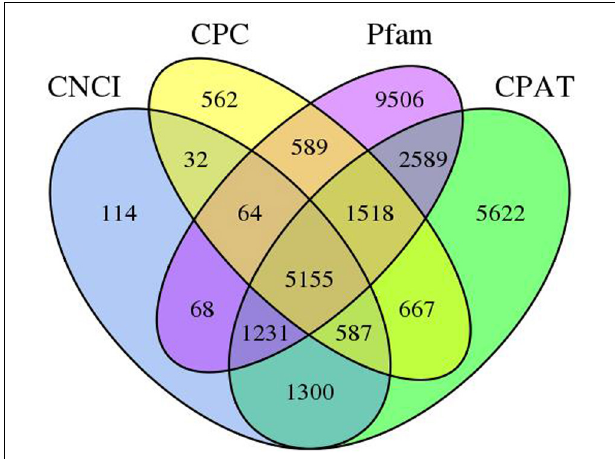
FIGURE 3 | LncRNAs predicted by the CNCI, CPAT, Pfam, and CPC protein structure domain analysis.